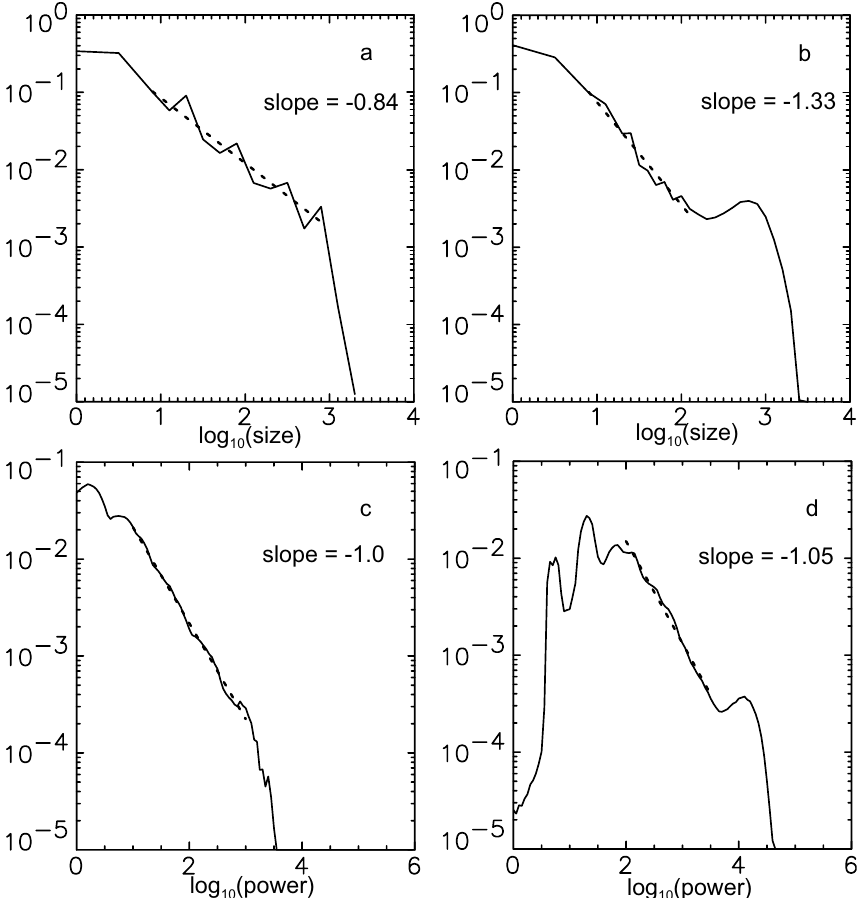
Fig. 6. Probability distribution of size (square) of individual transient: (a) during time when feedback is not active; (b) there are cells with active feedback. Probability distribution of power of individual transient: (c) during time when feedback is not active; (d) there are cells with active